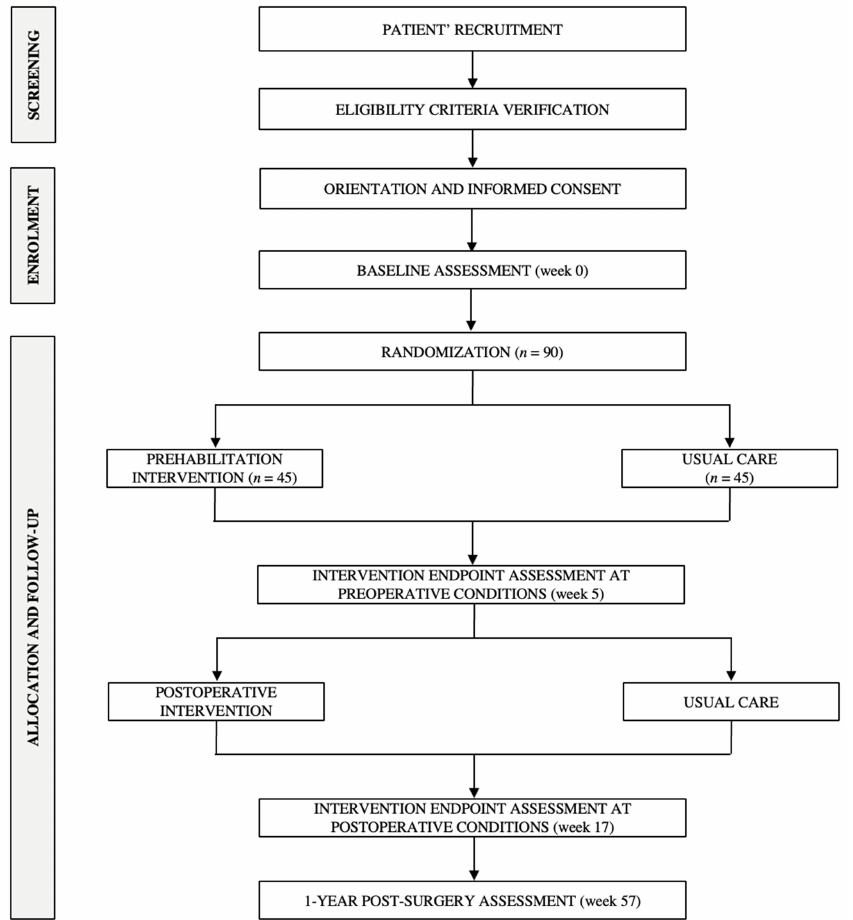
Figure 1. Flow diagram of the ONCOFIT study patients.